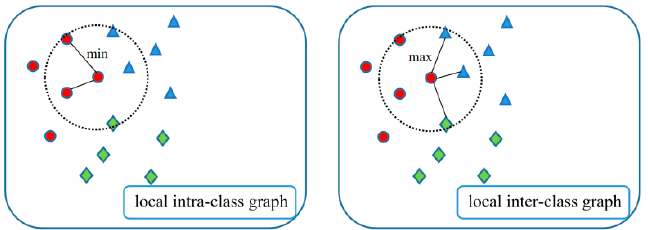
Figure 1. Example of local graph construction, where k = 5 and different shapes represent different classes of samples. classes of